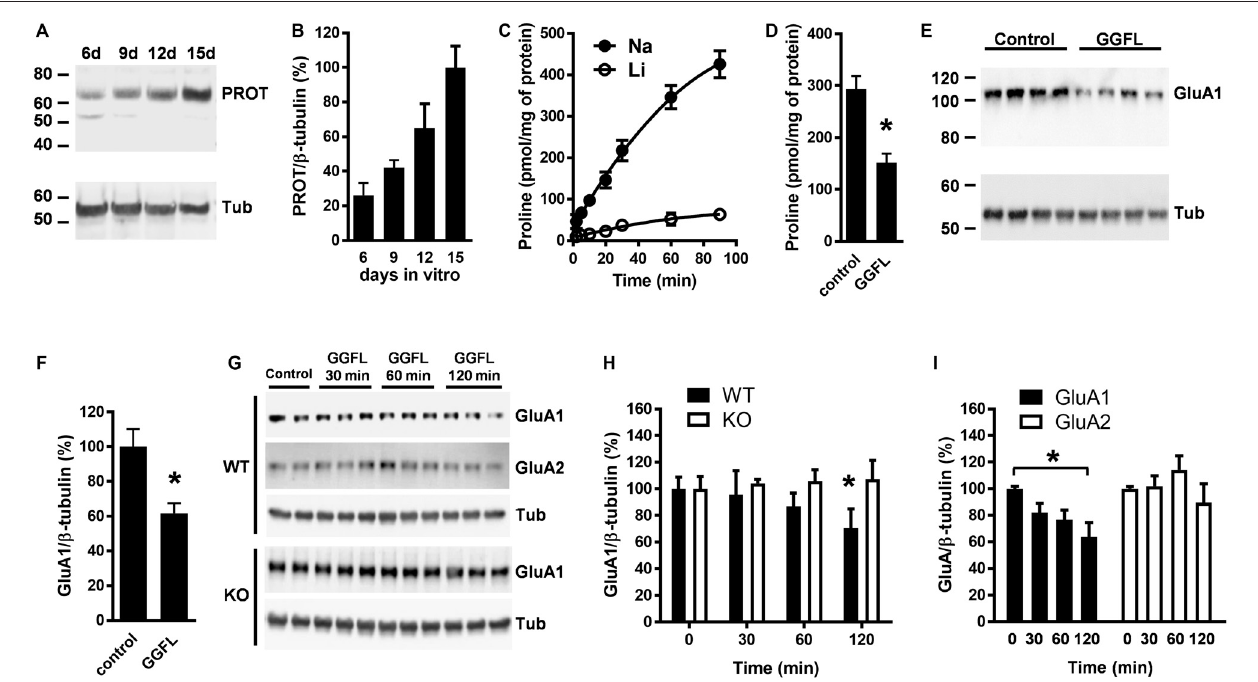
FIGURE 5 | PROT influences GluA1 receptor levels in cultured cortical neurons. (A) Lysates prepared from mouse cortical neurons cultured for the period indicated (in days) were analyzed by Western blotting using the PROT antibody and reprobed with the β -tubulin antibody. (B) Quantitative analysis of PROT immunoreactive band corrected by β -tubulin from three independent experiments. (C) Time course of L-proline accumulation into cortical neurons cultured after 14 days; Na + dependance was examined by isotonic substitution of assay NaCl (Na) with LiCl (Li). (D) Inhibition of L-proline transport by GGFL in cortical neurons; Na + dependent L-proline uptake was conducted for 60 min in the absence or presence of 50 µ M GGFL. (E,F) Treatment with 50 µ M GGFL for 120 min diminished GluA1 expression in lysates from cortical neurons. (G) Illustrative time-dependent Western blot assay of GluA1 and GluA2 abundance from cortical neuron lysates prepared from WT as well as of GluA1 from PROT − / − (KO) mouse, with or without 50 µ M GGFL. (H) Summary of GluA1 quantification obtained in mouse neuron lysates from three different experiments. (I) GluA2 expression is not affected in WT neurons upon incubation with GGFL. Data are presented as means ± SD. (D,F) Two-tailed Student’s t test; (H) two-way ANOVA with Bonferroni’s post hoc test; (I) one-way ANOVA with Bonferroni’s post hoc test; ∗ p < 0.05.